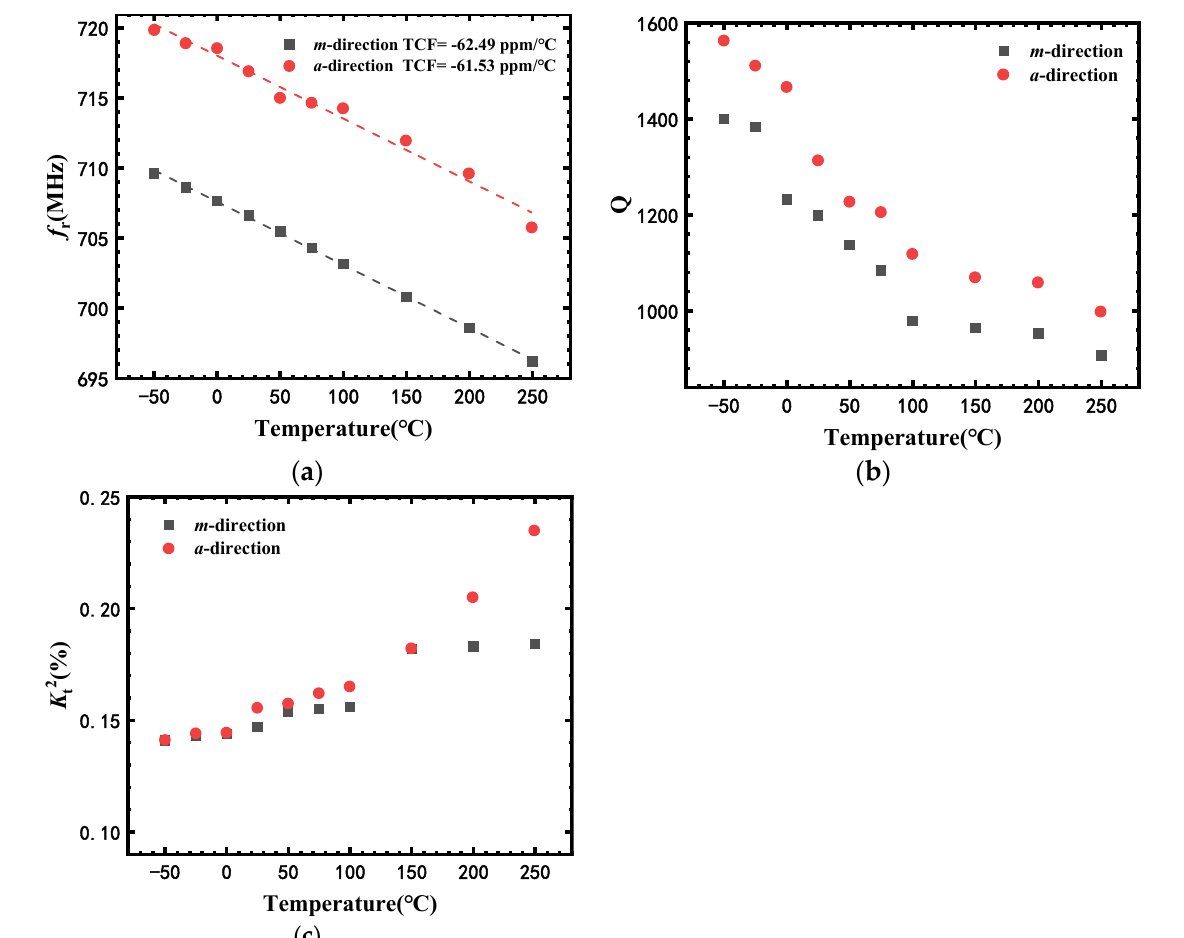
Figure 6. Temperature dependency of ( a ) f r , ( b ) Q , and ( c ) 𝐾 (cid:3047)(cid:2870) of sensors with different acoustic propagation directions.